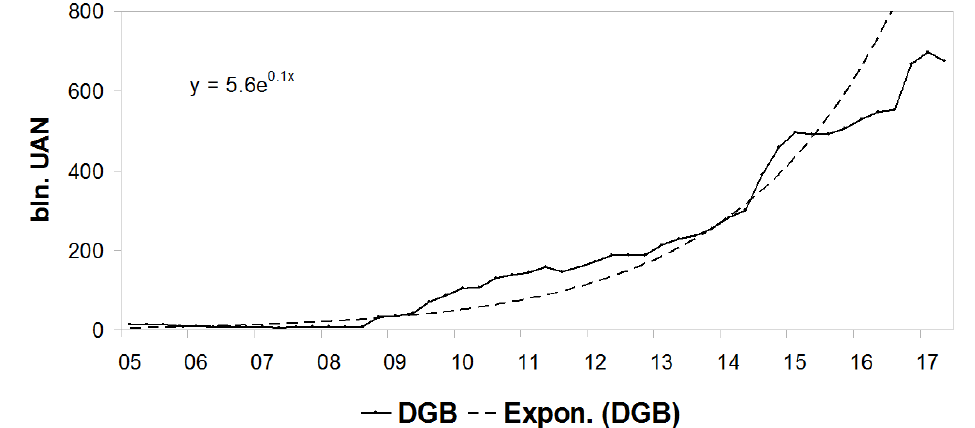
Figure 3. The dynamics of Domestic Government Bonds in circulation (DGB) Source: National Bank of Ukraine.